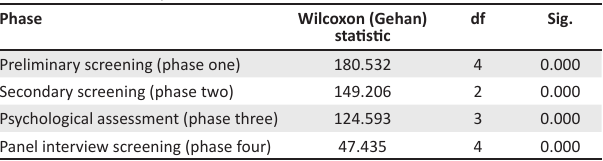
TABLE 7: Overall comparisons *